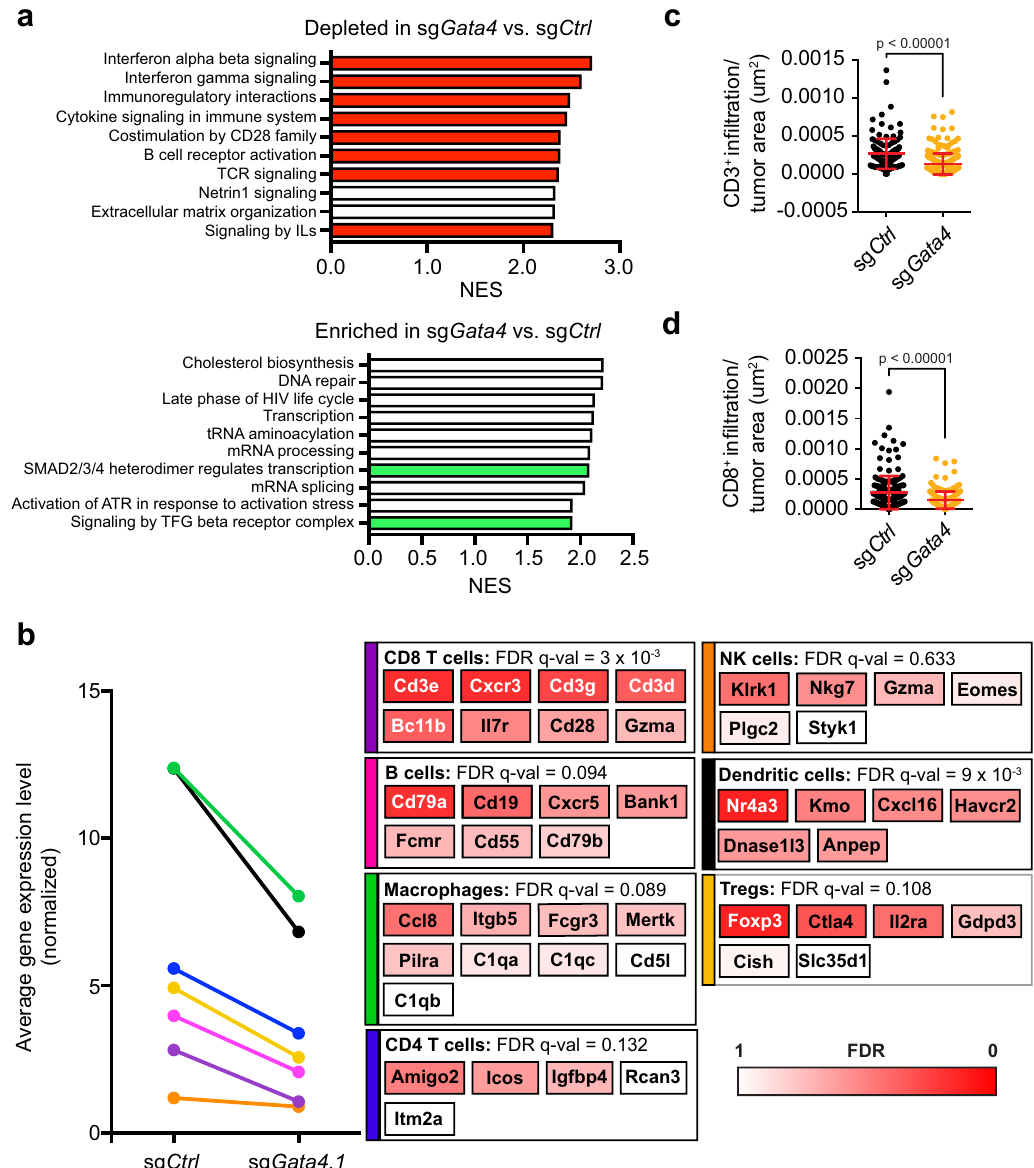
Fig. 2 Loss of Gata4 in vivo is associated with reduction of in fl ammatory pathways and results in reduced tumor-in fi ltrating lymphocytes. a RNA-seq was performed on bulk tumors and included both tumor and stromal cells. Individual tumors were micro-dissected from mouse lung tissue. GSEA on differentially expressed genes between sg Gata4 -targeted tumors and sg Ctrl- targeted tumors is shown; genesets of interest were derived from the curated genesets from the Reactome database. Genesets of interest that were depleted in sg Gata4 -targeted tumors versus sg Ctrl -targeted tumors are shown in red. Genesets of interest, which were enriched in sg Gata4 -targeted tumors versus sg Ctrl -targeted tumors are shown in green; 10 out of the top 16 differentially expressed genesets are shown. All genesets displayed have a statistically signi fi cant FDR < 0.01. b Sets of genes whose expression correlates with the abundance of different subsets of immune cells (see Supplementary Data 1) were analyzed for their expression in sg Gata4 -targeted tumors versus sg Ctrl -targeted tumors collected 16 weeks P.I. from the autochthonous KPC lung cancer model. Representative genes characterizing each immune cell type are shown with a heatmap representing the corresponding FDR q-value derived from the RNA-seq analysis of tumors. c Quanti fi cation of IHC of CD3 staining of serially sectioned lung lobes collected 16 weeks P.I. Error bars represent the mean ∓ SD and statistics derived from two-sided t -test. Data are derived from n = 4 mice totalling n = 139 tumors for sg Ctrl and n = 6 mice totalling n = 262 tumors for sg Gata4 . d Quanti fi cation of IHC of CD8 staining of serially sectioned lung lobes collected 16 weeks P.I. Error bars represent the mean ∓ SD, and statistics were derived from a two-sided t -test. Data are derived from n = 4 mice totalling n = 183 tumors for sg Ctrl and n = 6 mice totalling n = 171 tumors for sg Gata4